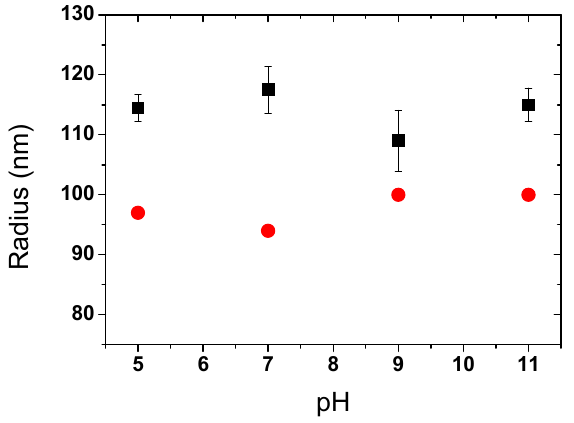
Figure 8. Effect of pH on the radius of PAA-PAH-PAsp triple-layer modified SPBs measured by DLS and SAXS (C NaCl = 10 mM). Symbols denote: ( ■ , black) DLS, ( ● , red) SAXS.